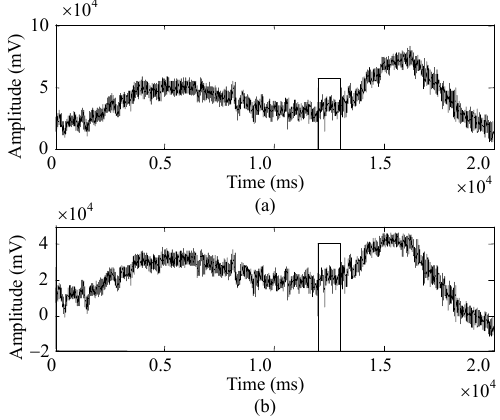
Fig. 6 False alarm signals: (a) signal I and (b) signal Q.